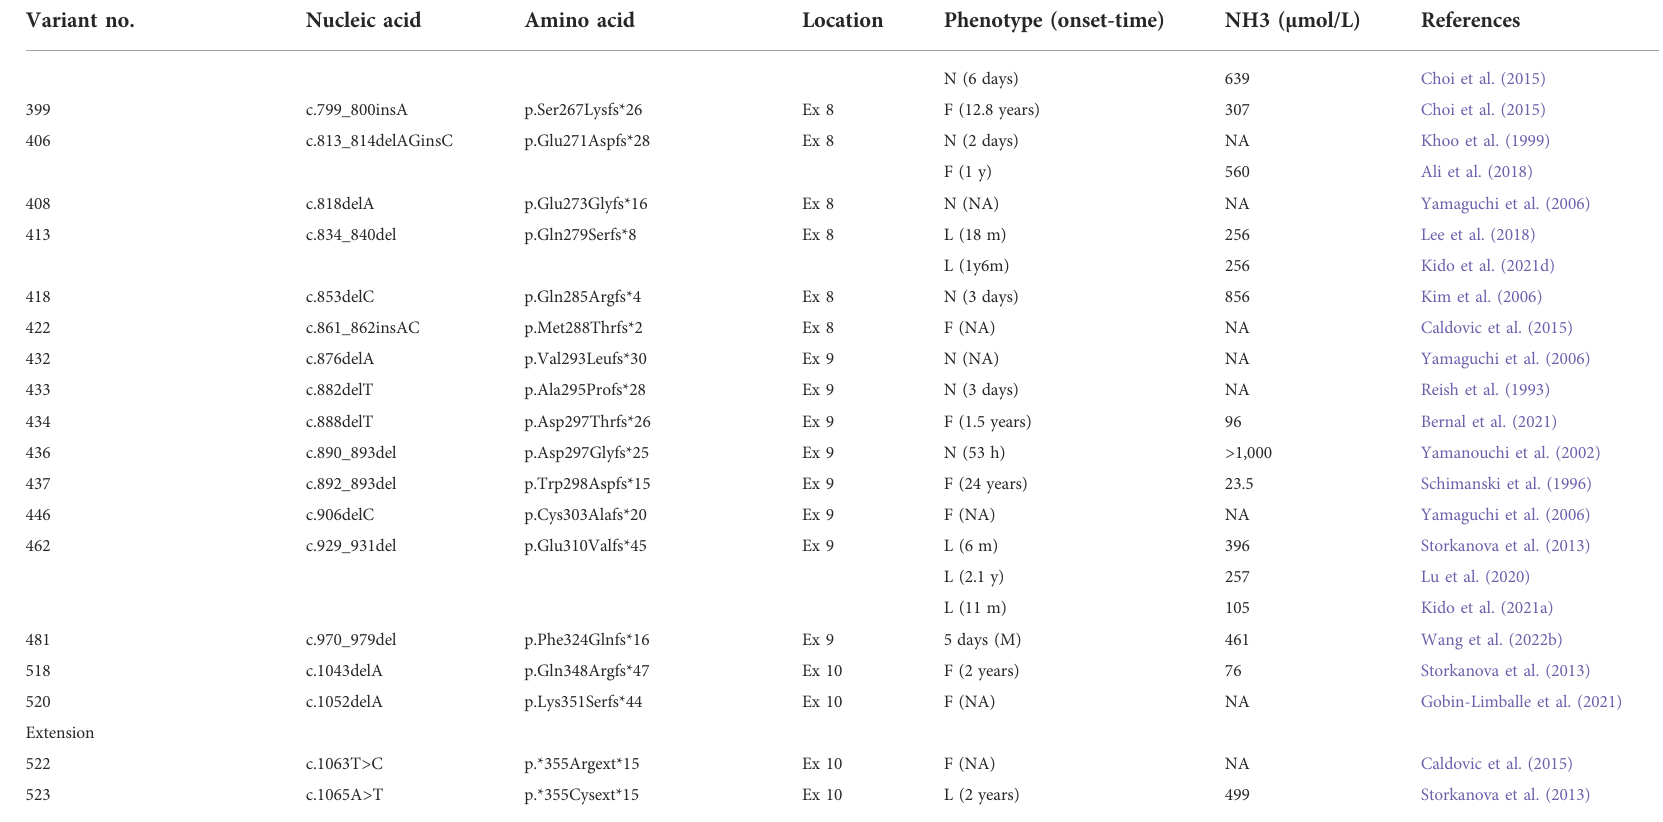
TABLE 1 ( Continued ) Variants in the OTC gene and